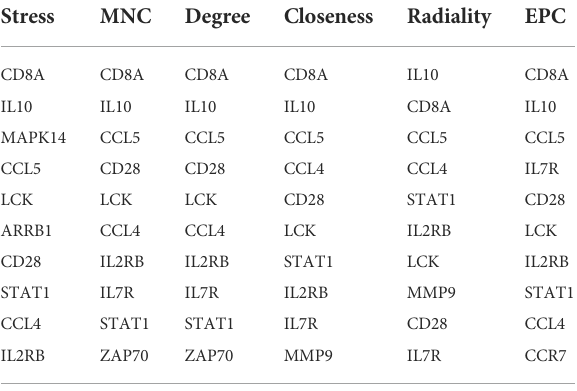
TABLE 1 The top 10 core immune-related DEGs rank in cytoHubba. Stress